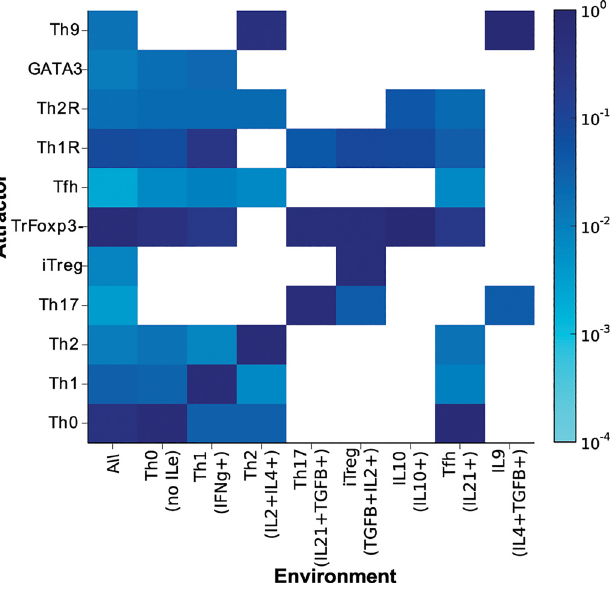
Fig 4. Effect of the micro-environment on CD4+ T cell differentiation as determined using the TSRN model. The values of the extrinsic signals of the TSRN were fixed according to different polarizing micro- environments. The basins of attraction of the resulting attractors were plotted on a logarithmic scale. The following micro-environments were studied: combinations of all extrinsic cytokines, no extrinsic cytokines (Th0), IFN- γ e (Th1), IL-4e and IL-2e (Th2), IL-21e and TGF- β e (Th17), TGF- β e and IL-2e (iTreg), IL-10e (IL10), IL-21e (Tfh), and IL-4e and TGF- β e